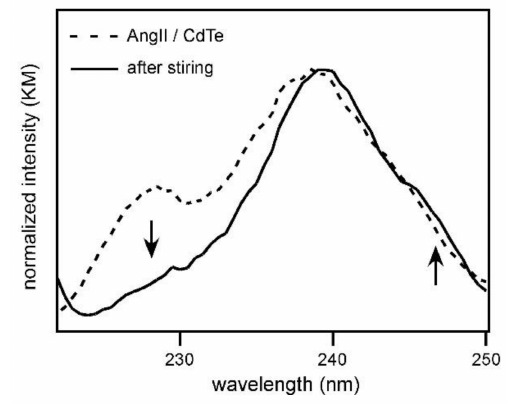
Figure 5. Diffuse reflectance spectra of mixed crystals of angiotensin II (AngII) and CdTe before and after stirring for 1 h.